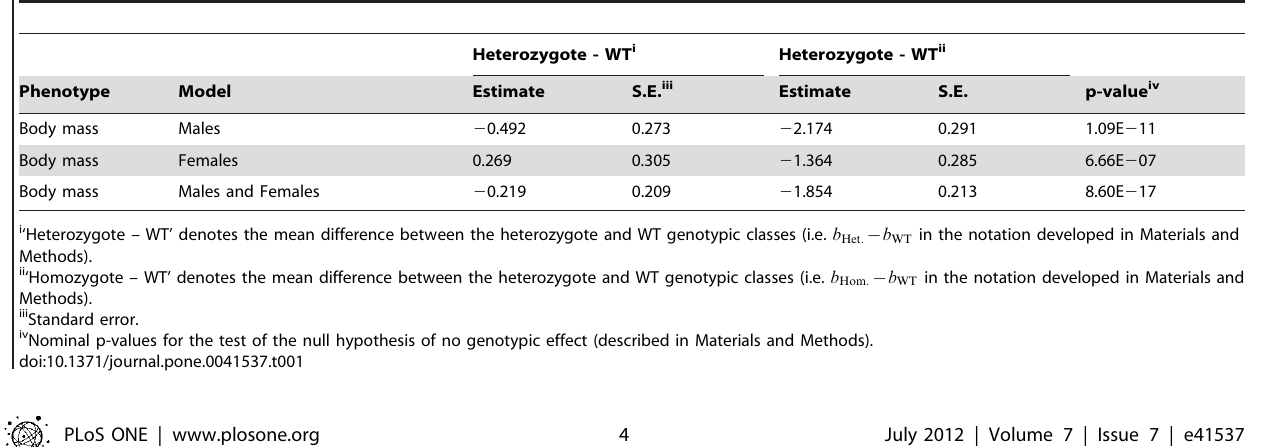
Table 1. Repeated measures ANOVA—results for Negr1 -KO